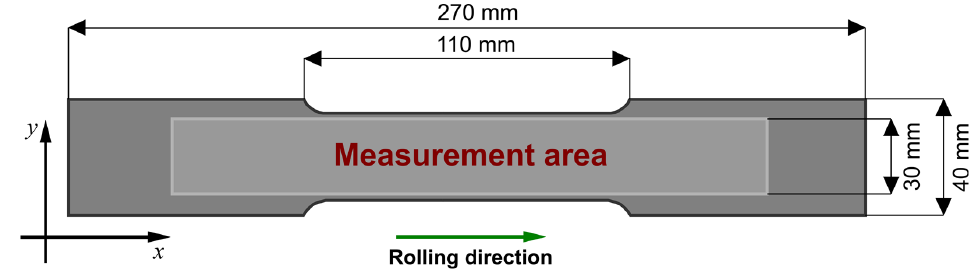
Figure 1. Shape and dimensions of the samples used in the experiments.